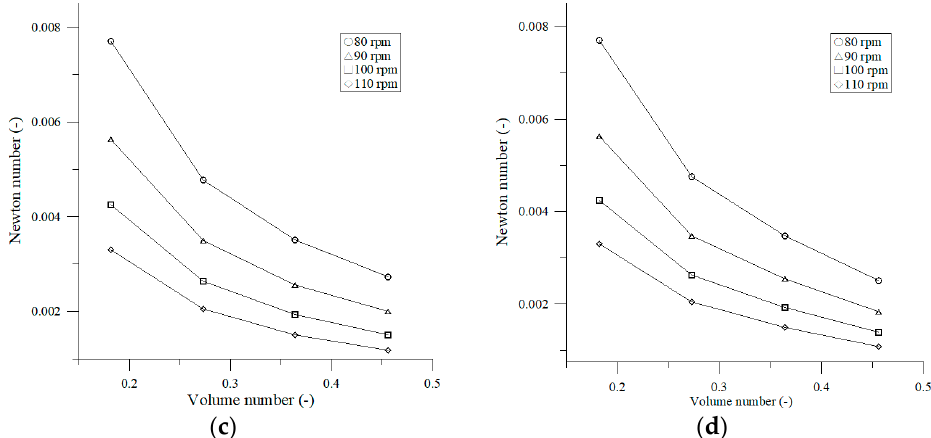
Figure 5. Relationship between Newton number and volume number of different shaking frequencies. ( a ) Water; ( b ) 5 vol% glycerin; ( c ) 10 vol% glycerin; ( d ) 20 vol% glycerin.